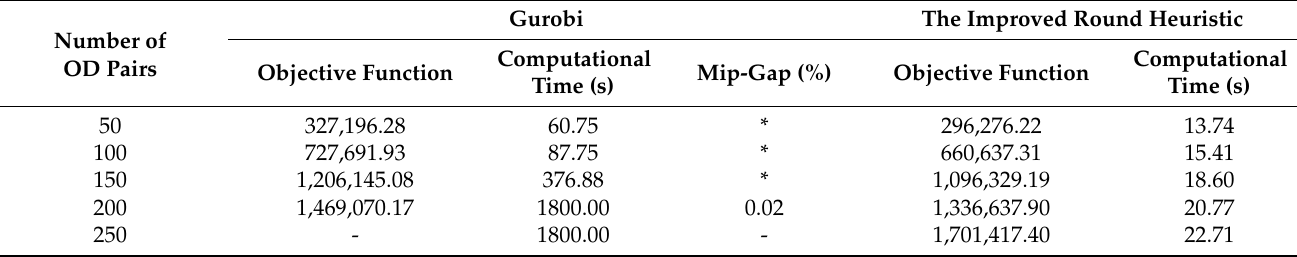
Table 3. Performance comparison of the improved round heuristic and Gurobi.